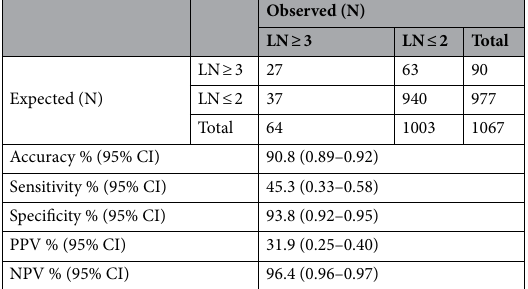
Table 6. Predictive accuracy of the nomogram in patients who meet the ACOSOG-Z0011 criteria. LN , Lymph node; PPV , Positive predictive value; NPV , Negative predictive value; CI , Confidence